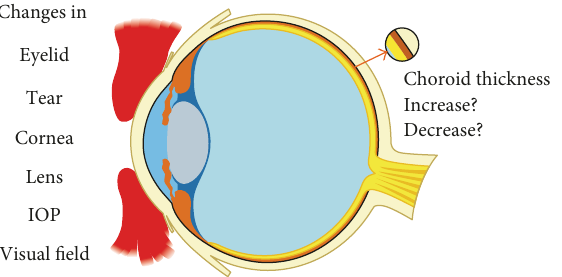
Figure 2: Ocular changes during